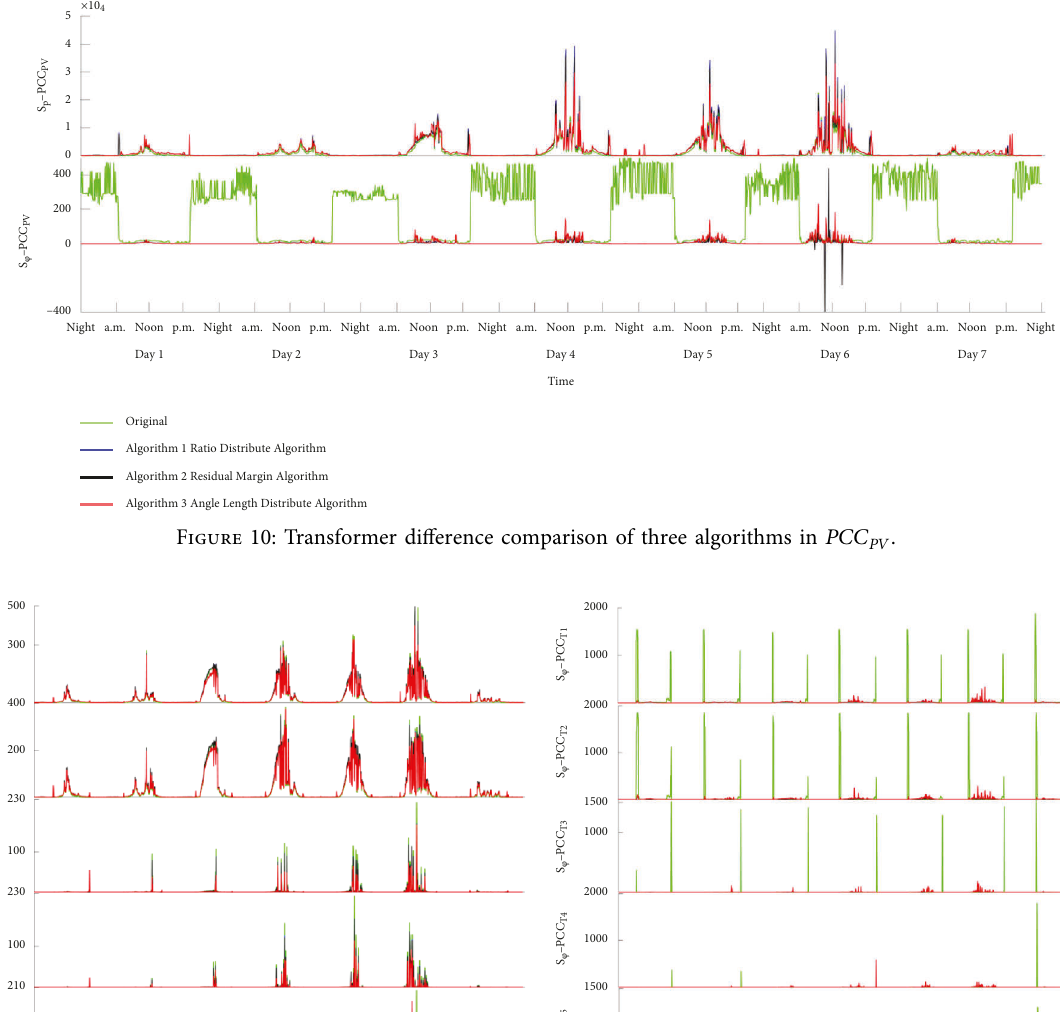
AlgorithmOriginal AlgorithmAlgorithm 1 Ratio Distribute AlgorithmAlgorithm 2 Residual Margin Algorithm 3 Angle Length Distribute Figure 11: Inverter array difference comparison of three algorithms in PCC